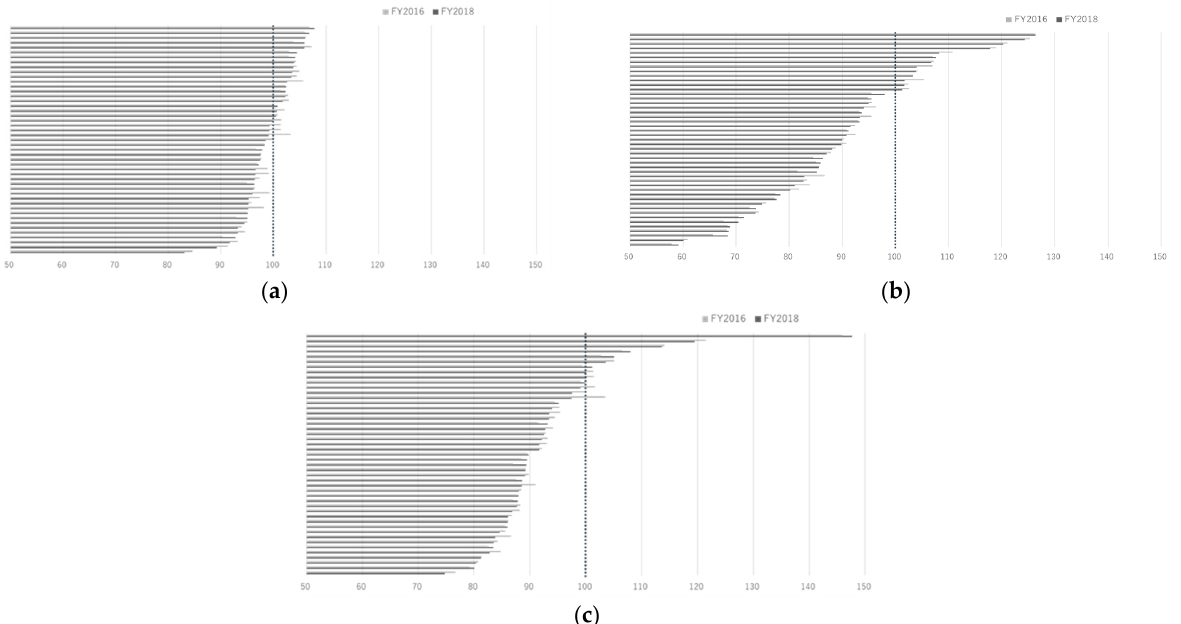
Figure 3. ( a ) The Standardized Claim Ratios (SCRs) of dental caries among 47 prefectures in FY2016 and FY2018. ( b ) The SCRs of periodontal disease among 47 prefectures in FY2016 and FY2018. ( c ) The SCRs of tooth loss among 47 prefectures in FY2016 and FY2018.